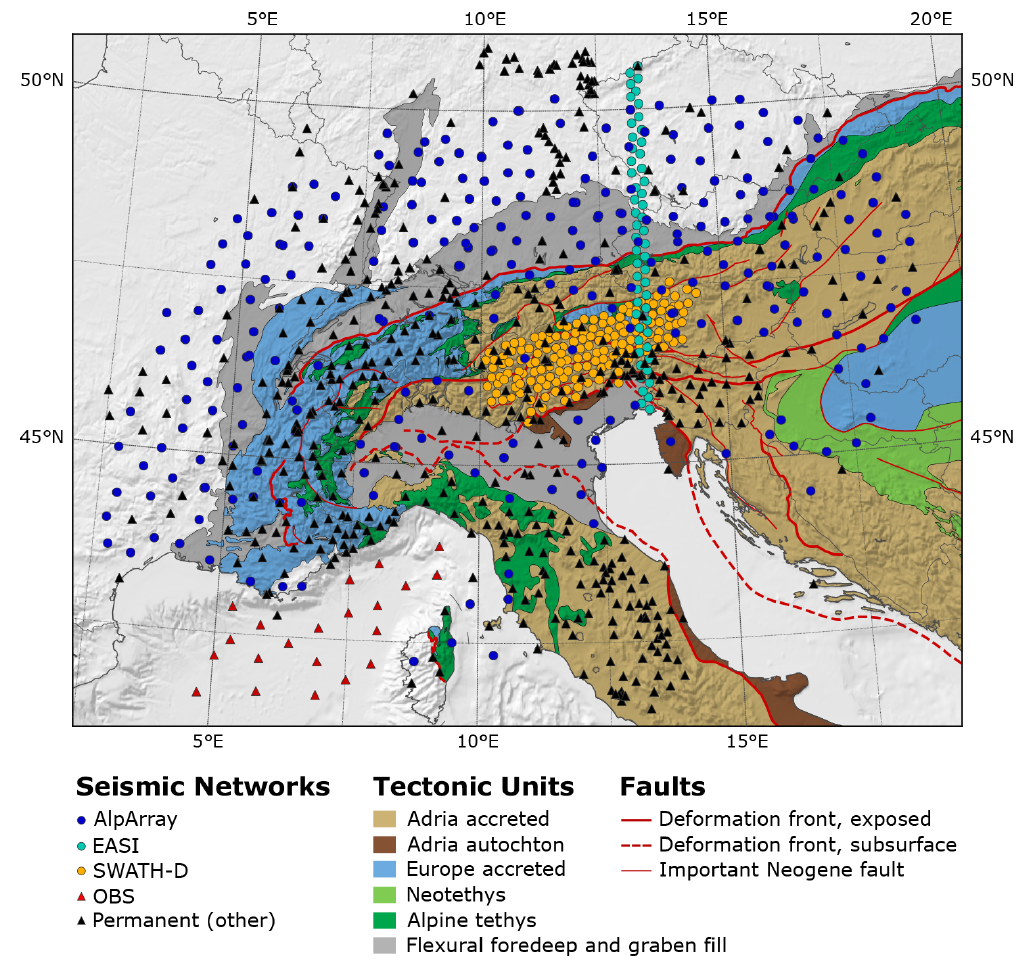
Figure 1. Tectonic map of the Alpine chains compiled by Handy (2021) showing different seismic networks and temporary experiments, tectonic units and major fault systems. Tectonic units and major lineaments simplified from Bigi et al. (1990), Schmid et al. (2004, 2008), Froitzheim et al. (1996), Handy et al. (2010) and Bousquet et al.